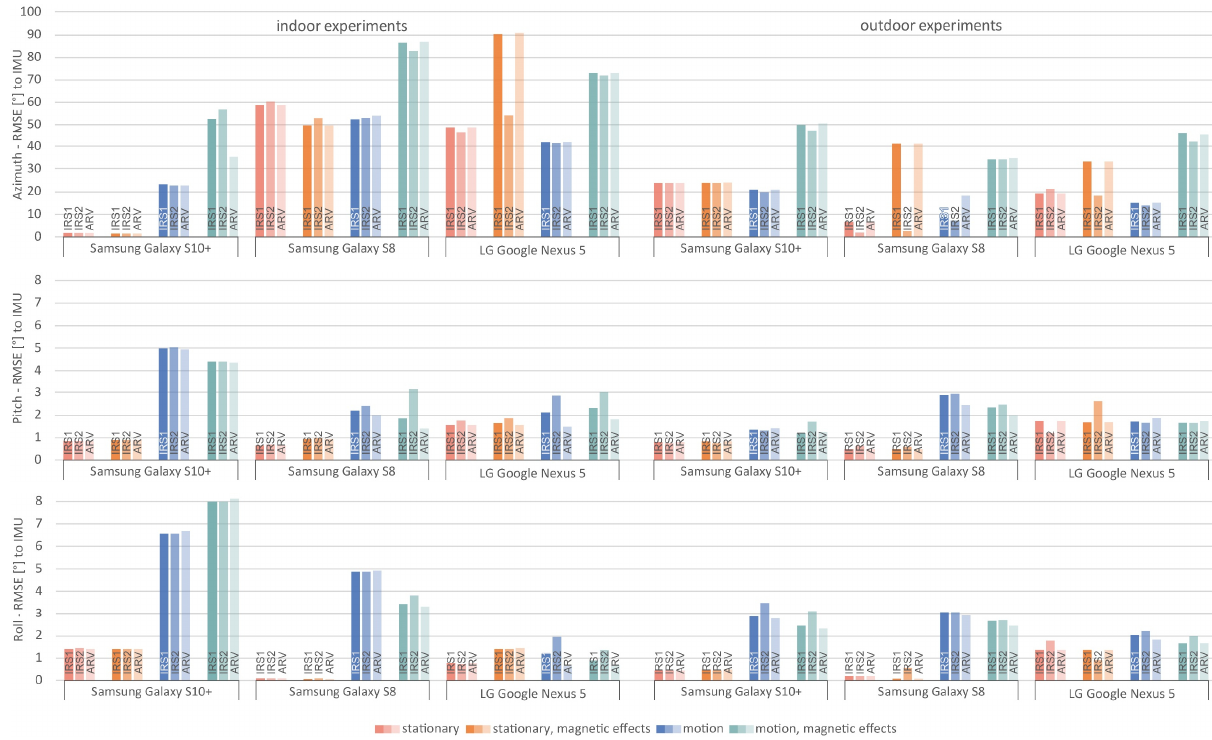
Figure 3. Accuracy investigation of smartphone-based rotation parameters. Accuracy is defined by the RMSE calculated from the deviations between the rotation parameters from the smartphone and the reference values from IMU Spatial .